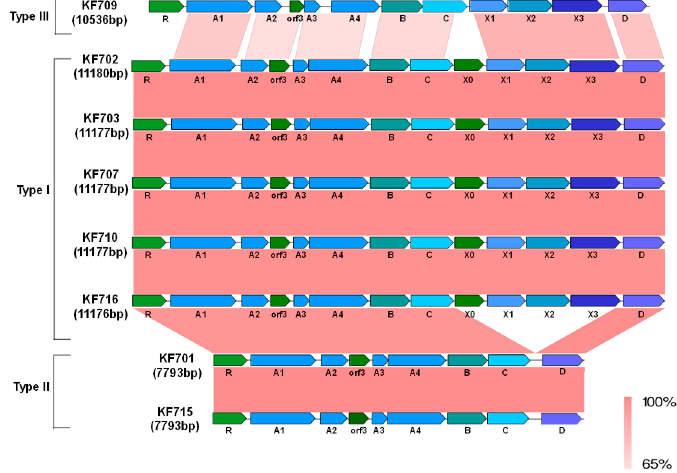
Figure 4. Comparison of the bph gene clusters of KF strains belonging to groups I–III (types I–III). The shading in pink to red shows the identity (65–100%) of the gene clusters as indicated at the bottom of the figure. R, bphR ; A1, bphA1 ; A2, bphA2 ; A3, bphA3 ; A4, bphA4 ; B, bphB ; C, bphC ; D, bphD ; X0, bphX0 , X1, bphX1 ; X2, bphX2 ; and X3, bphX3 .